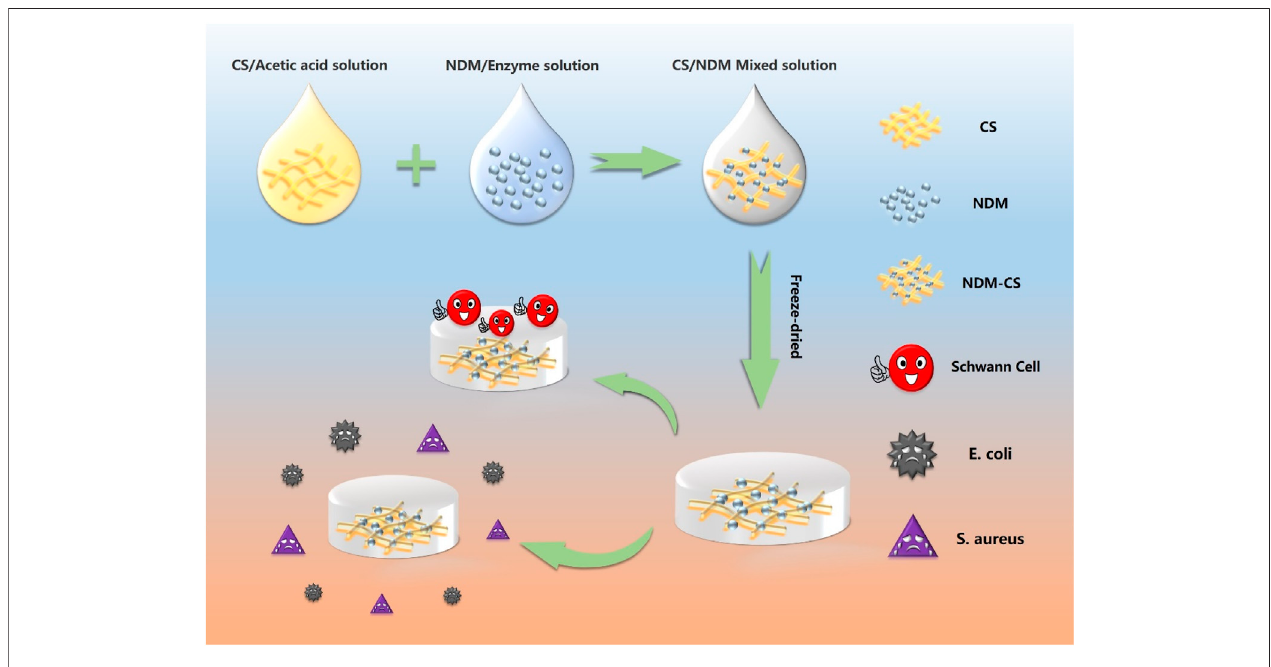
FIGURE 1 | Schematic illustration of the preparation of NDM-CS composite scaffold and the experiment.